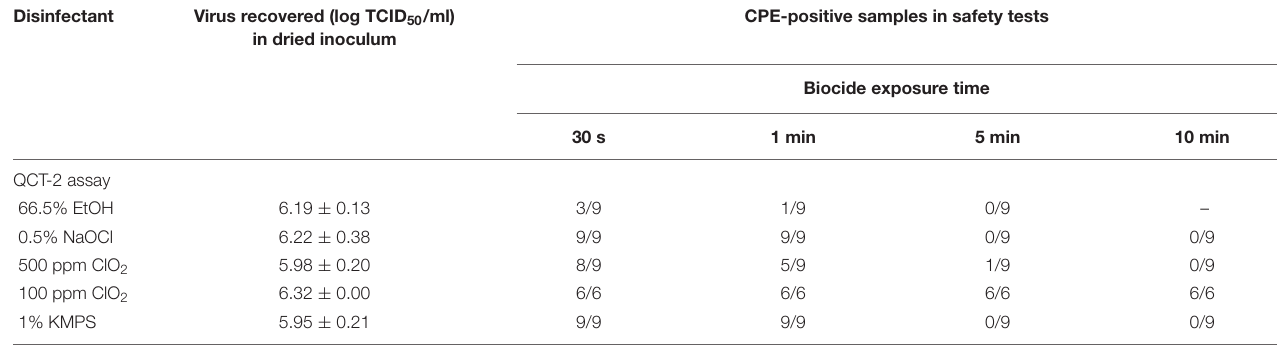
TABLE 2 | Number of tissue culture-treated wells showing a cytopathic effect following treatment with disinfectants and disinfectant pre-soaked wipes during safety testing during the QCT-2 and Wiperator assays, respectively. Disinfectant Virus recovered (log TCID 50 /ml) in dried